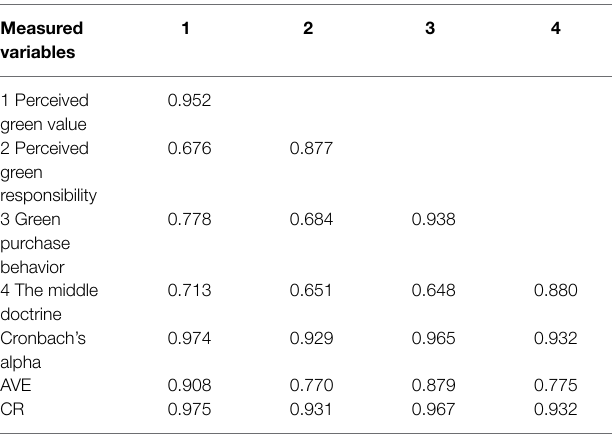
TABLE 2 | Reliability and validity